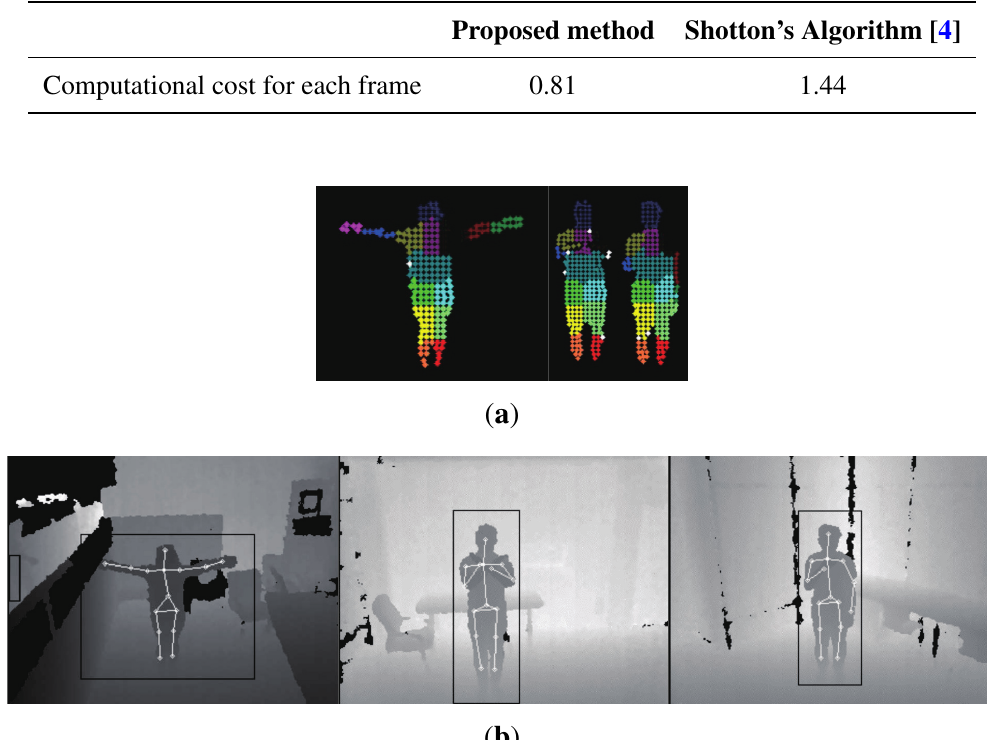
Table 4. Computational cost of human pose estimation (unit: GFlops).